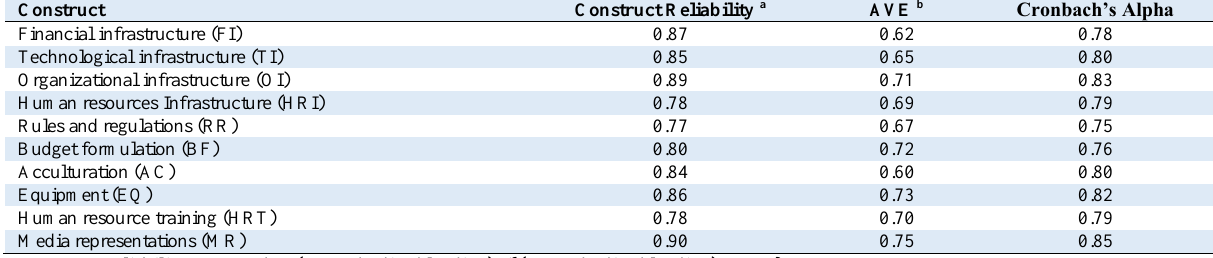
Table 1. Summary of constructs and their measurement properties Construct Construct Reliability